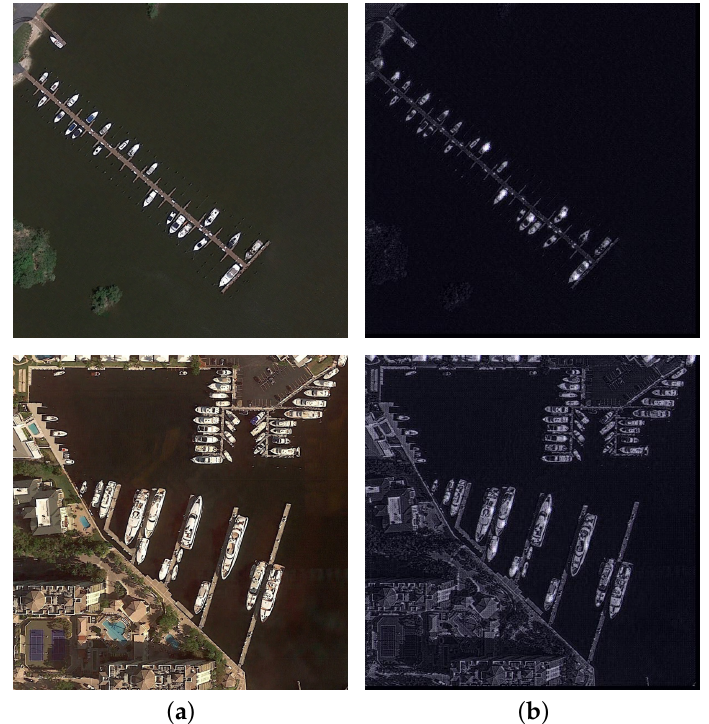
Figure 5. Image-level alignment examples. ( a ) The optical images. ( b ) The generated SAR